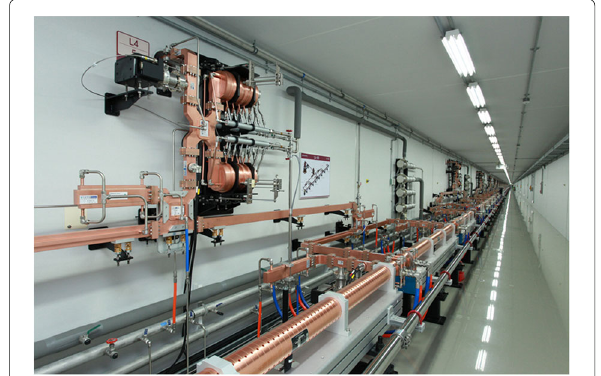
Fig. 6 S-band accelerating structures inside the PAL-XFEL linac